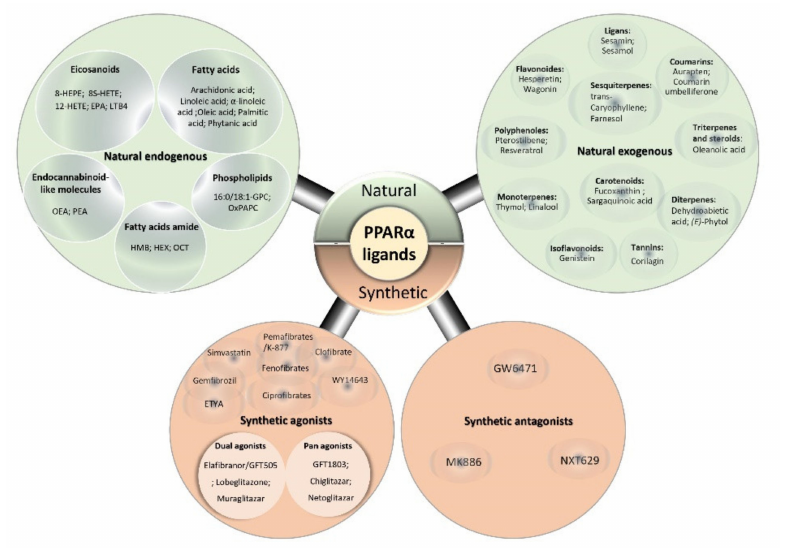
Figure 5. Diagram of different types and classes of PPAR α ligands. The natural ligands type encompasses endogenous natural ligands (fatty acids [28,80–82], eicosanoids [31,83–85], phospho- lipids [75,86], fatty-acid amide [87] and endocannabinoid-like molecules [77], and exogenous natural ligands [30,88] (polyphenol flavonoids, isoflavonoids, monoterpenes, sesquiterpenes, diterpenes, triterpenes and steroids, carotenoids, coumarins, ligans, and tannins). The synthetic ligands type in- cludes various classes of synthetic agonists [28,31,62,67,69,88–91] with various activation and binding modes (single [88,92], dual [28,91,93,94] and pan agonists [28,92]), and synthetic antagonists [89,90,95]. Abbreviations: 8-HEPE: 8-hydroxyeicosapentaenoic acid, 12-HETE: 12-hydroxyeicosatetraenoic acid, 8S-HETE: 8 (S)-hydroxyeicosatetraenoic acids, 16:0/18:1-GPC: phosphatidylcholine(1-palmitoyl-2- oleoyl-sn-glycerol-3-phosphocholine), EPA: eicosapentaenoic acid (20:5), ETYA: eicosatetraynoic acid, HEX: hexadecanamide, HMB: 3-hydroxy-(2,2)-dimethyl butyrate, OCT:9-octadecenamide, OEA: oleoyl-ethanolamide, OxPAPC: oxidized 1-palmitoyl-2-arachidonoyl-sn-glycero-3-phosphocholine, PEA: